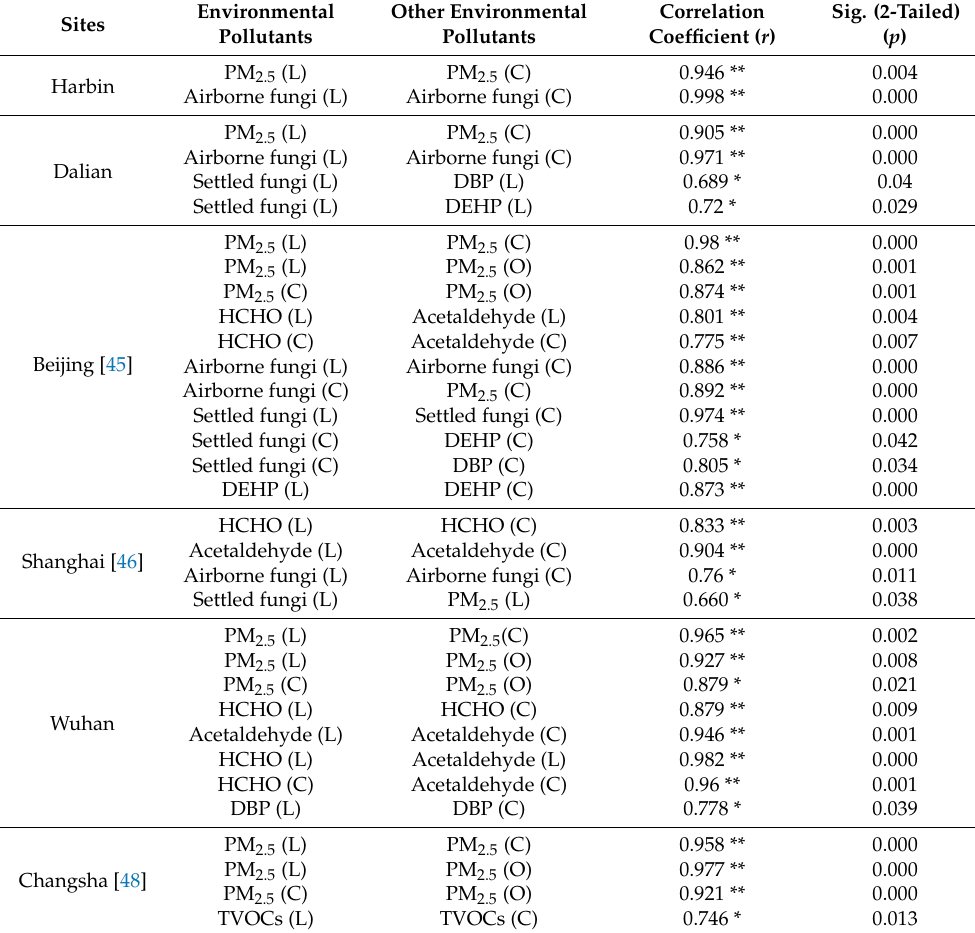
Table 6. Pearson correlation coefficients for household environmental pollutants in six